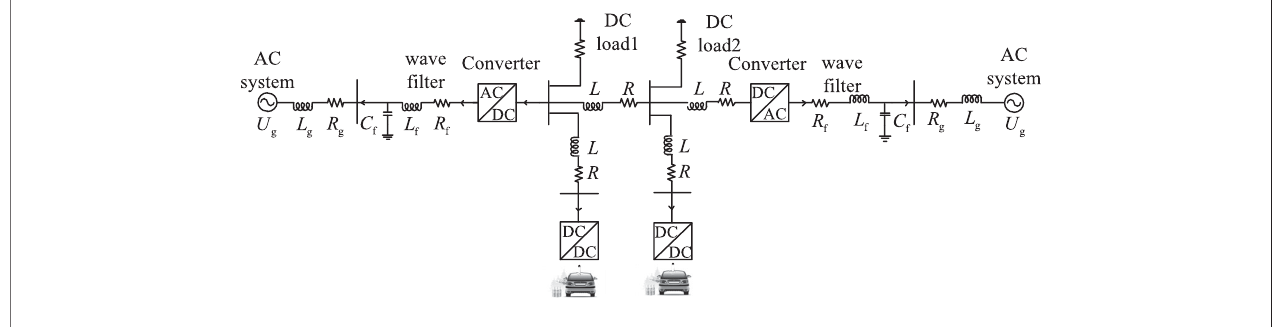
FIGURE 1 | Structure drawing of double-end DC distribution system with electric